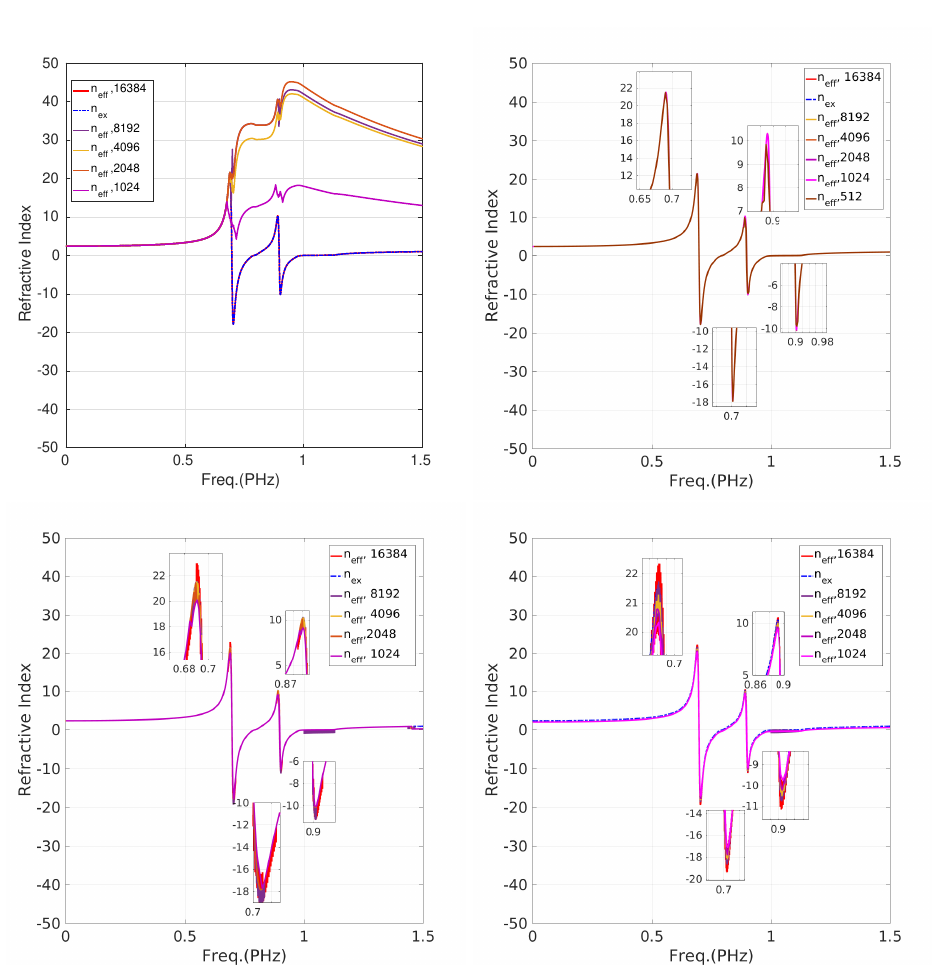
Figure 5. Plot of n ef f ( ω ) , as a function of n s and n ex ( ω ) for the MM with d ef f = 300 nm over frequency band [ 0,1.5 ] PHz. Top left : PUNWOS method; top right : PUNW HT method; bottom left : K-K relations; bottom right : PUNW KK method. The insets magnify n ef f ( ω ) around its peaks.